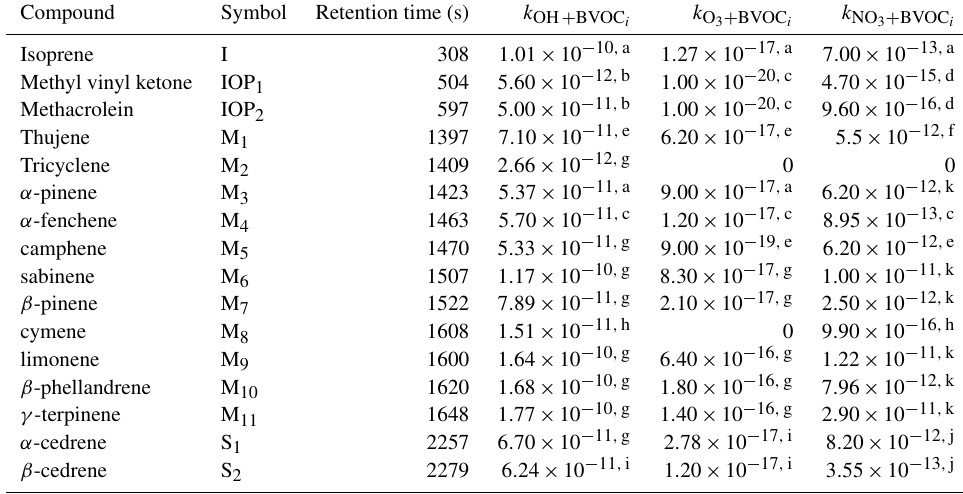
Table 1. Compound identities on an example chromatogram and associated rate constants (cm 3 molec. − 1 s − 1 ) for OH, ozone, and nitrate. Compound Symbol Retention time (s) Isoprene